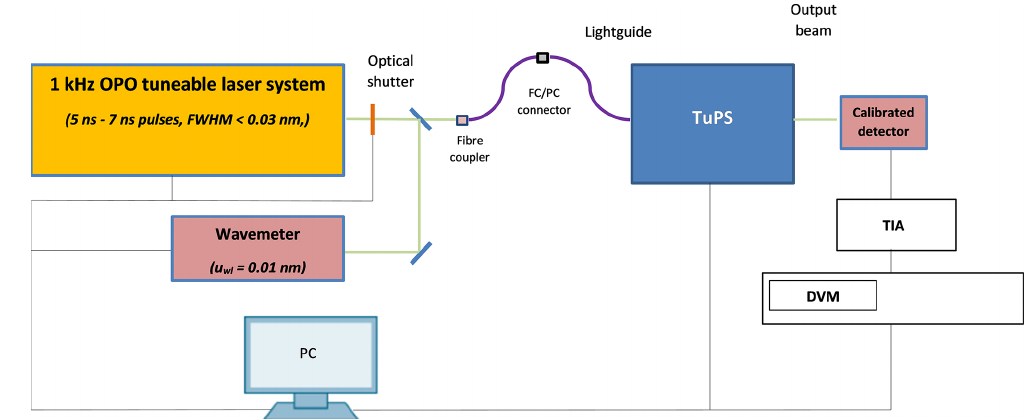
Figure 3. Schematic diagram of the TuPS characterisation measurement setup.